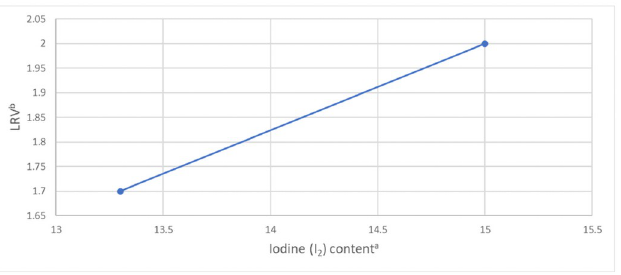
Fig 1. The correlation between the iodine content and LRV. a The iodine (I 2 ) content of the test samples (microgram) b LRV (log reduction value) is the reduction of virus compared to the virus control.